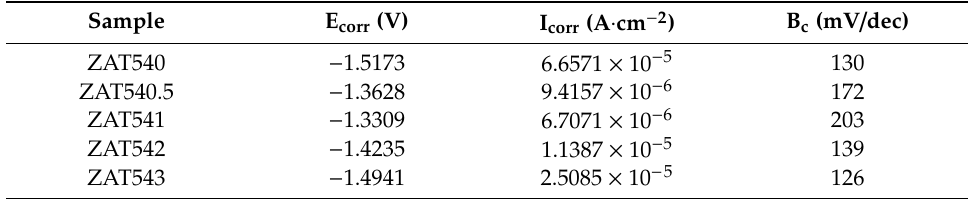
Table 3. Potentiodynamic polarization test results of extruded Mg–5Zn–4Al–xSn alloys in 3.5 wt % NaCl solution at room